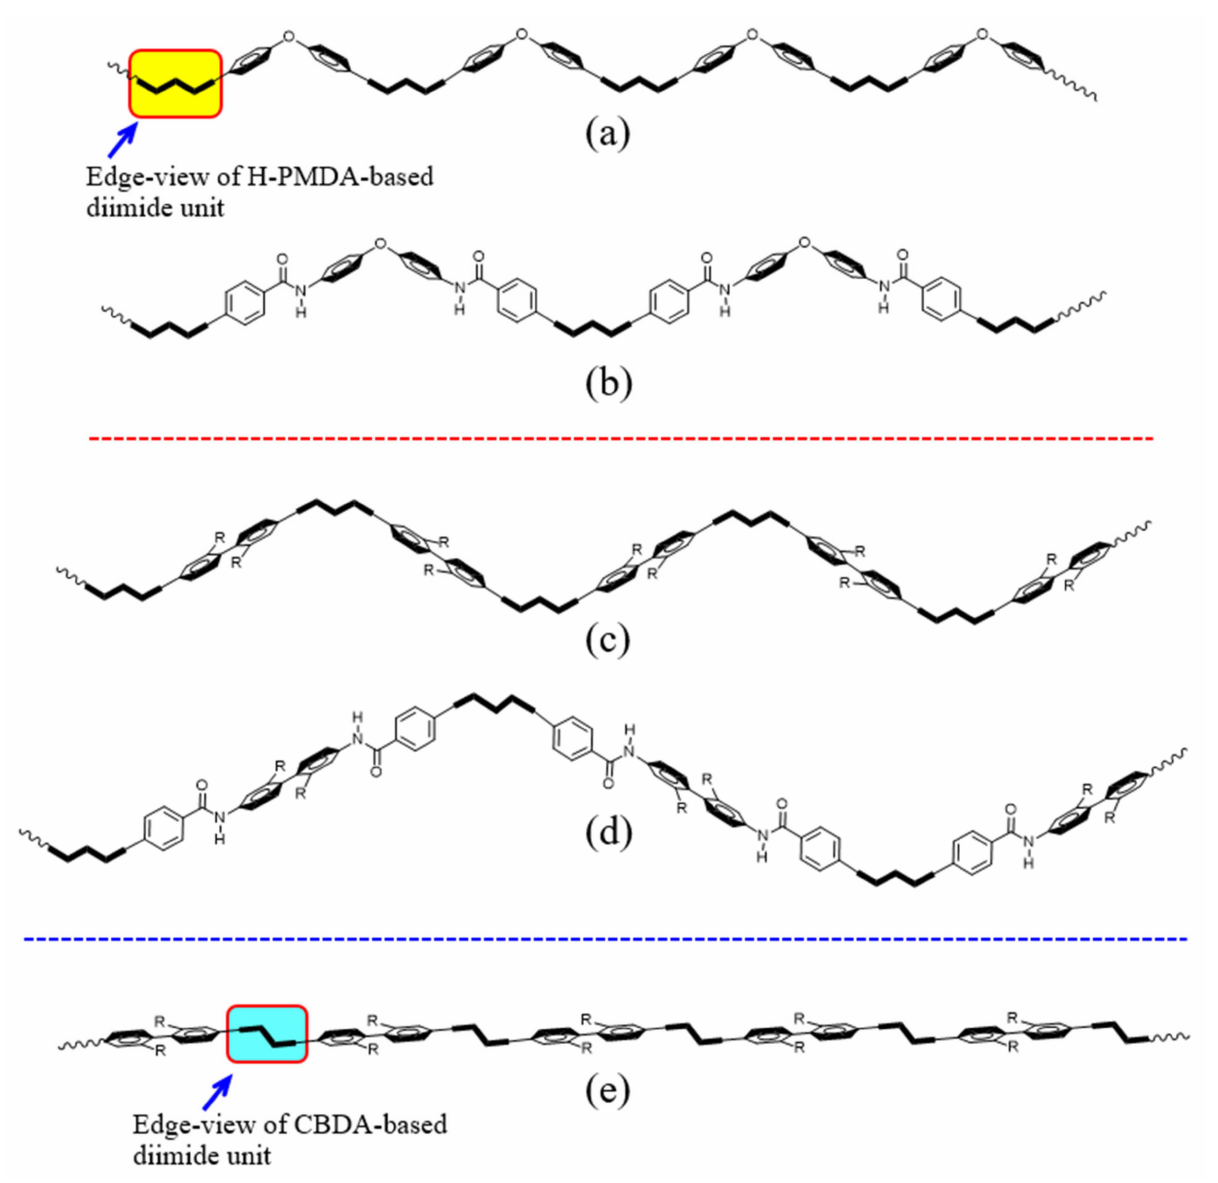
Figure 12. Schematic drawings of the extended chains for typical H-PMDA-based PIs: ( a ) H-PMDA/4,4 (cid:48) -ODA; ( b ) H-PMDA/AB-44ODA; ( c ) H-PMDA/TFMB or H-PMDA/ m -TOL; ( d ) H-PMDA/AB-TFMB or H-PMDA/AB- m TOL. The extended chain for CBDA/TFMB is shown ( e ) for